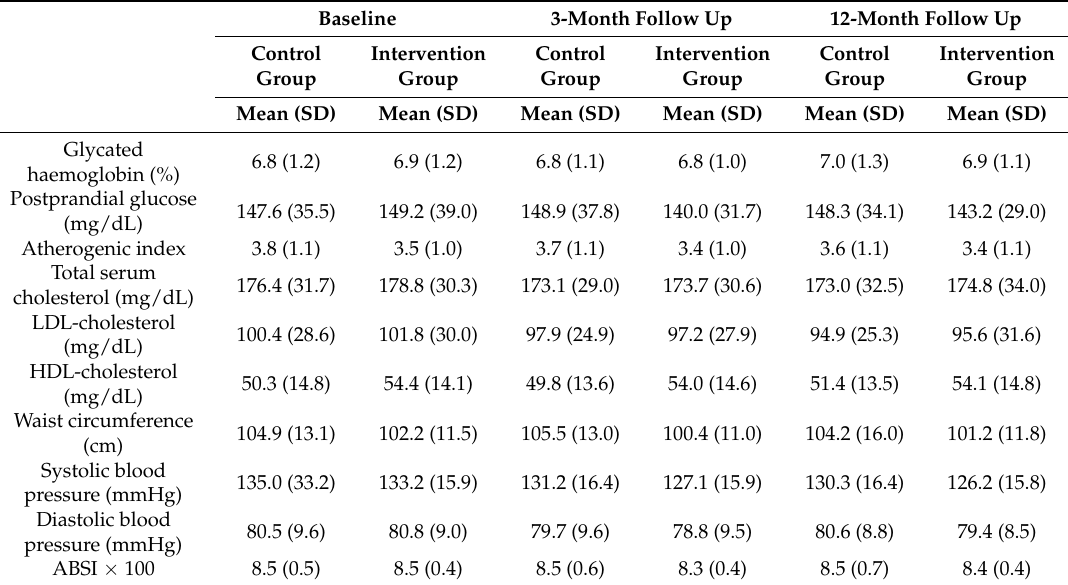
Table 4. Clinical variables throughout the study.